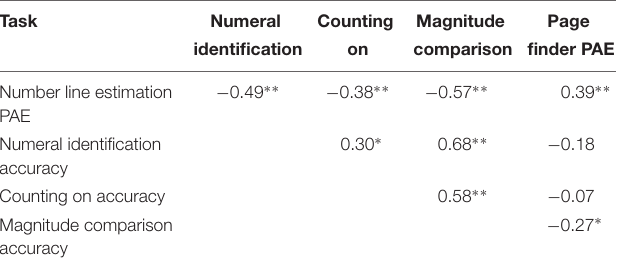
TABLE 3 | Pairwise correlations between tasks.